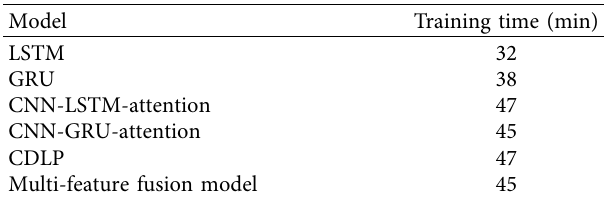
Table 5: Comparison of model training time of the multifeature fusion model and baseline